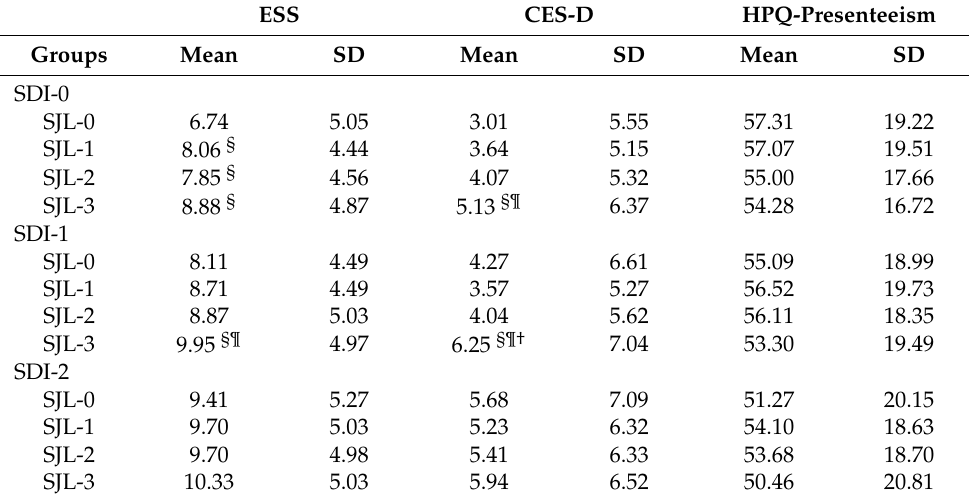
Table 2. Mean and SD of the scales for daytime function measures in each category. ESS